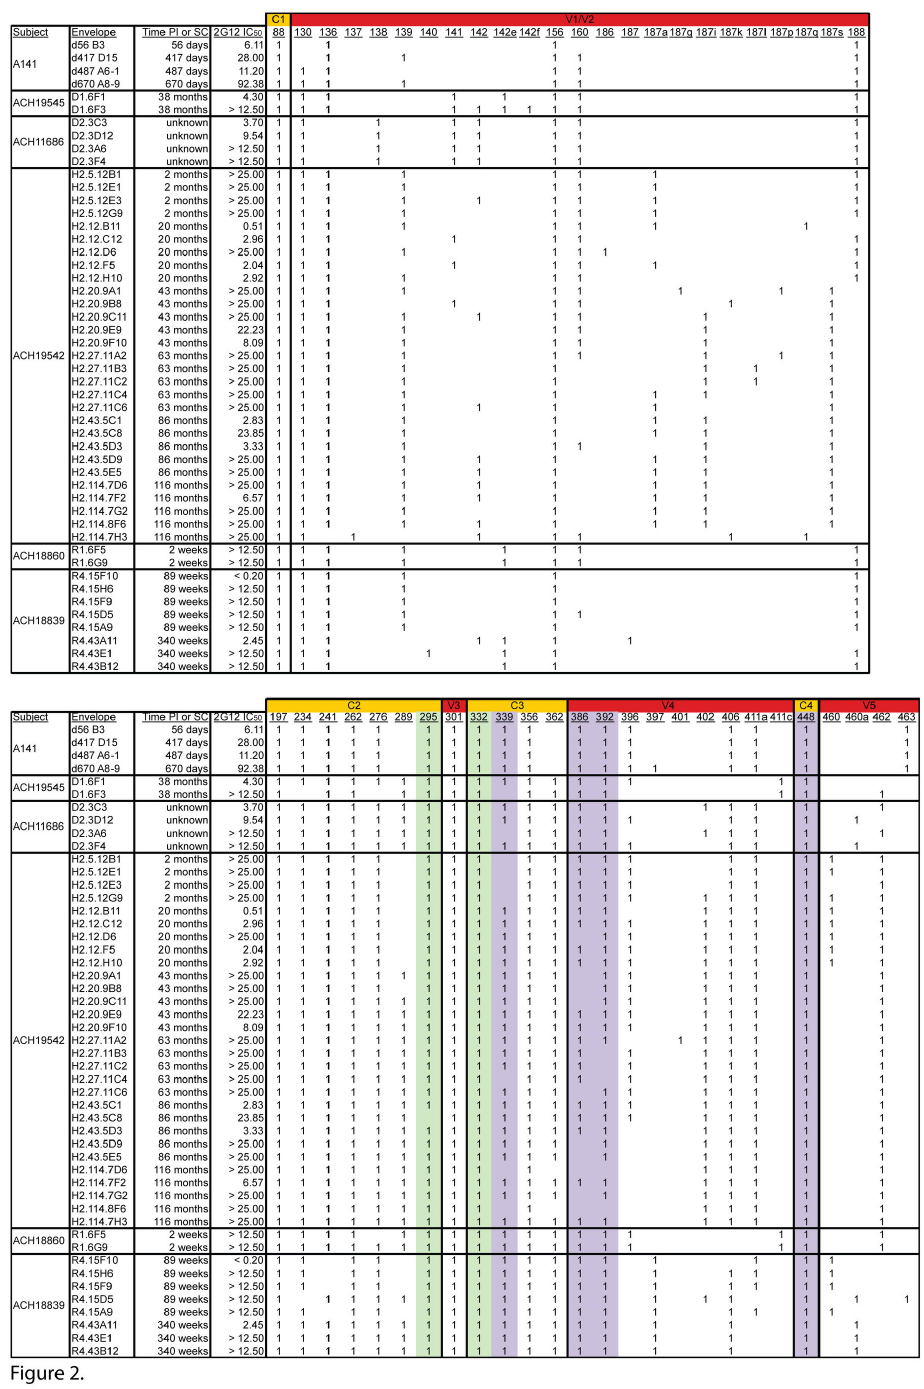
Figure 2. PNGS changes in different clade B Env quasispecies. Regions of Envelope are noted in the top bar and below are the PNGS positions. All protein sequences were aligned to HXB2 (accession # AF033819) and were analyzed with the Aminotrack webserver (http://apps.sbri.org/AminoTrack/). 1: Presence of PNGS at a given amino acid position. Green boxes indicate the essential PNGS and purple boxes indicate the accessory PNGS for 2G12 recognition. 2G12 IC (PI) for the envelopes from the A141 macaque are indicated. Neutralization data and time since seroconversion (SC) for subjects ACH19545, ACH11686, ACH 18860 and ACH18839 from the Amsterdam cohort are reported per Quakkelaar et al. [24]. 2G12 IC (µg/mL) and time since SC for subject ACH19542 from the Amsterdam cohort are adapted from Bunnik et al. [23].. doi: 10.1371/journal.pone.0075277.g002 PLOS ONE |